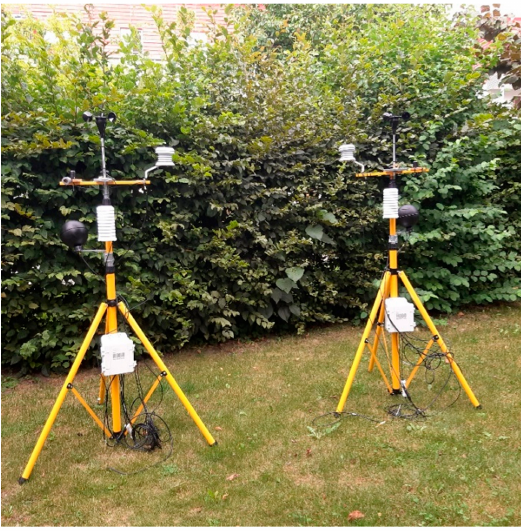
Figure 5. iButton sensor calibration. The weather stations were placed at Hohenzollernplatz and Bordeauxplatz squares, which differ in shape and the type of pavement. In both locations, the stations were placed in open areas, as representative unshaded areas within the study site, surrounded by vegetation, and distant from streets and building facades (Figure 6). The measured summer period was representative of a hot day with maximum air temperature higher than 29 ◦ C, no clouds, and wind speed below 2 m/s. The measured winter period was representative of a typical cold day, average Ta 0.6 ◦ C and wind speed around 1 m/s (Figure 7).